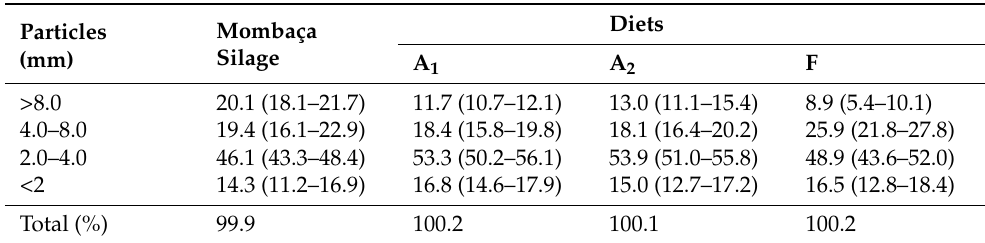
Table 5. Average of particle size distribution of the Mombaça silage and the diets of the traditional feedlot (October 2012). Values expressed in %.